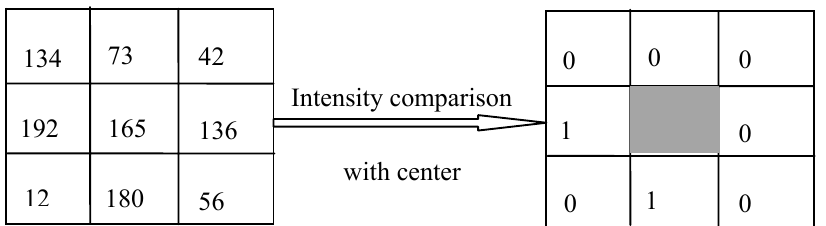
Figure 1. Example of an LBP